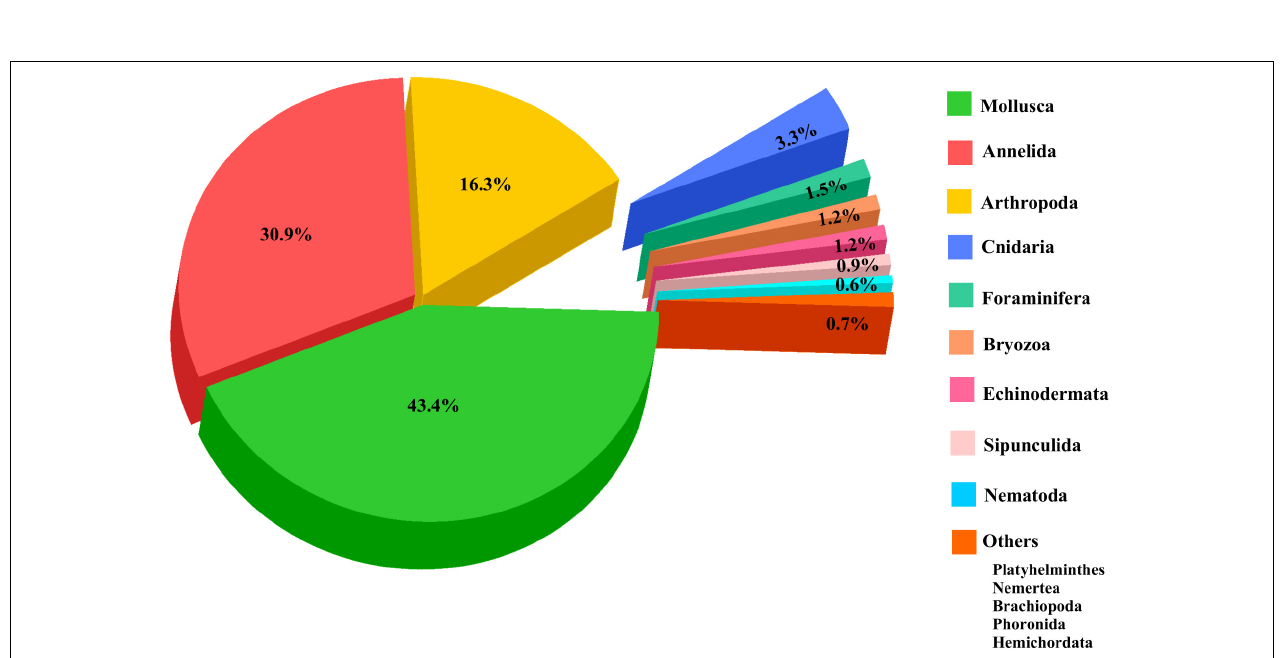
FIGURE 3 | Phylum level composition percentage of macrobenthic taxa recorded and listed in Supplementary Table 1 .